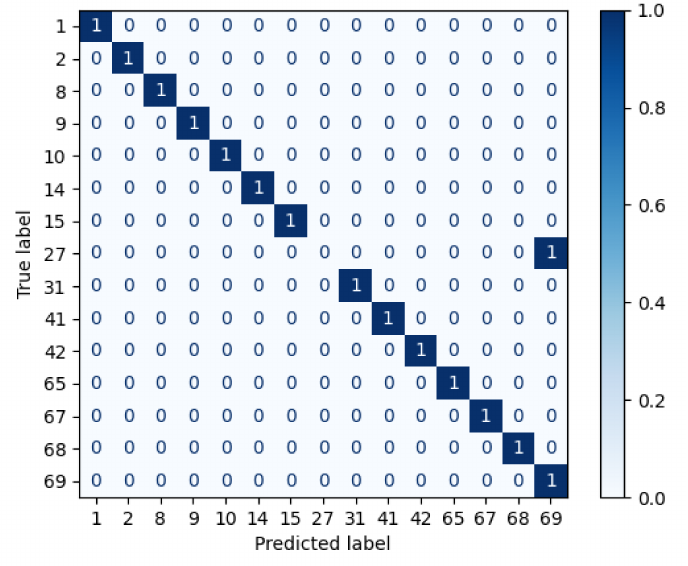
Figure 11. Confusion matrix with the 100% visible of the facial ROI.